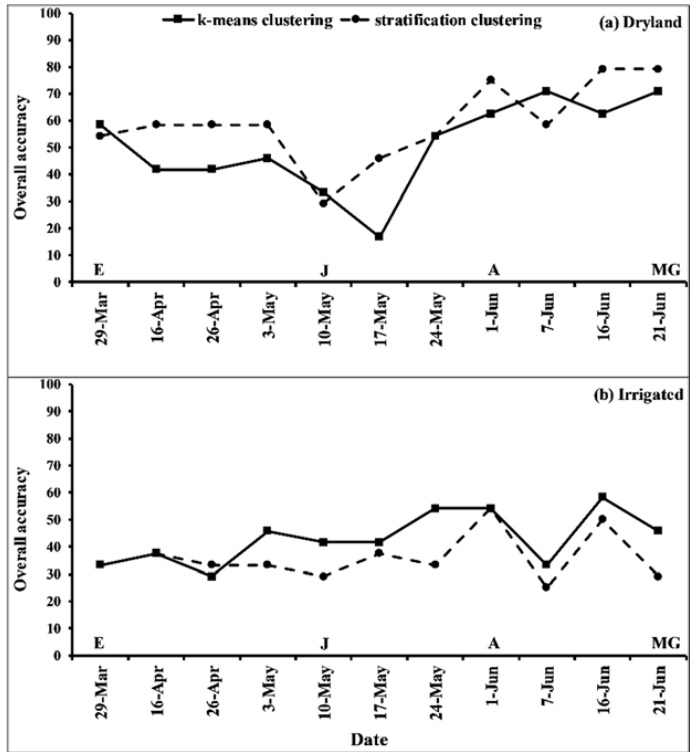
Figure 6. Overall accuracy results from contingency table comparing mean grain yield classes to mean NDVI classes using k-means clustering (solid line with squares) and stratification clustering (dashed line with circles). The overall accuracy is presented across 11 dates for site year I under ( a ) dryland conditions and ( b ) irrigated conditions. Critical growth stages are indicated as A = anthesis growth stage, E = early spring growth stage, J = jointing growth stage, and MG = mid-grain filling growth